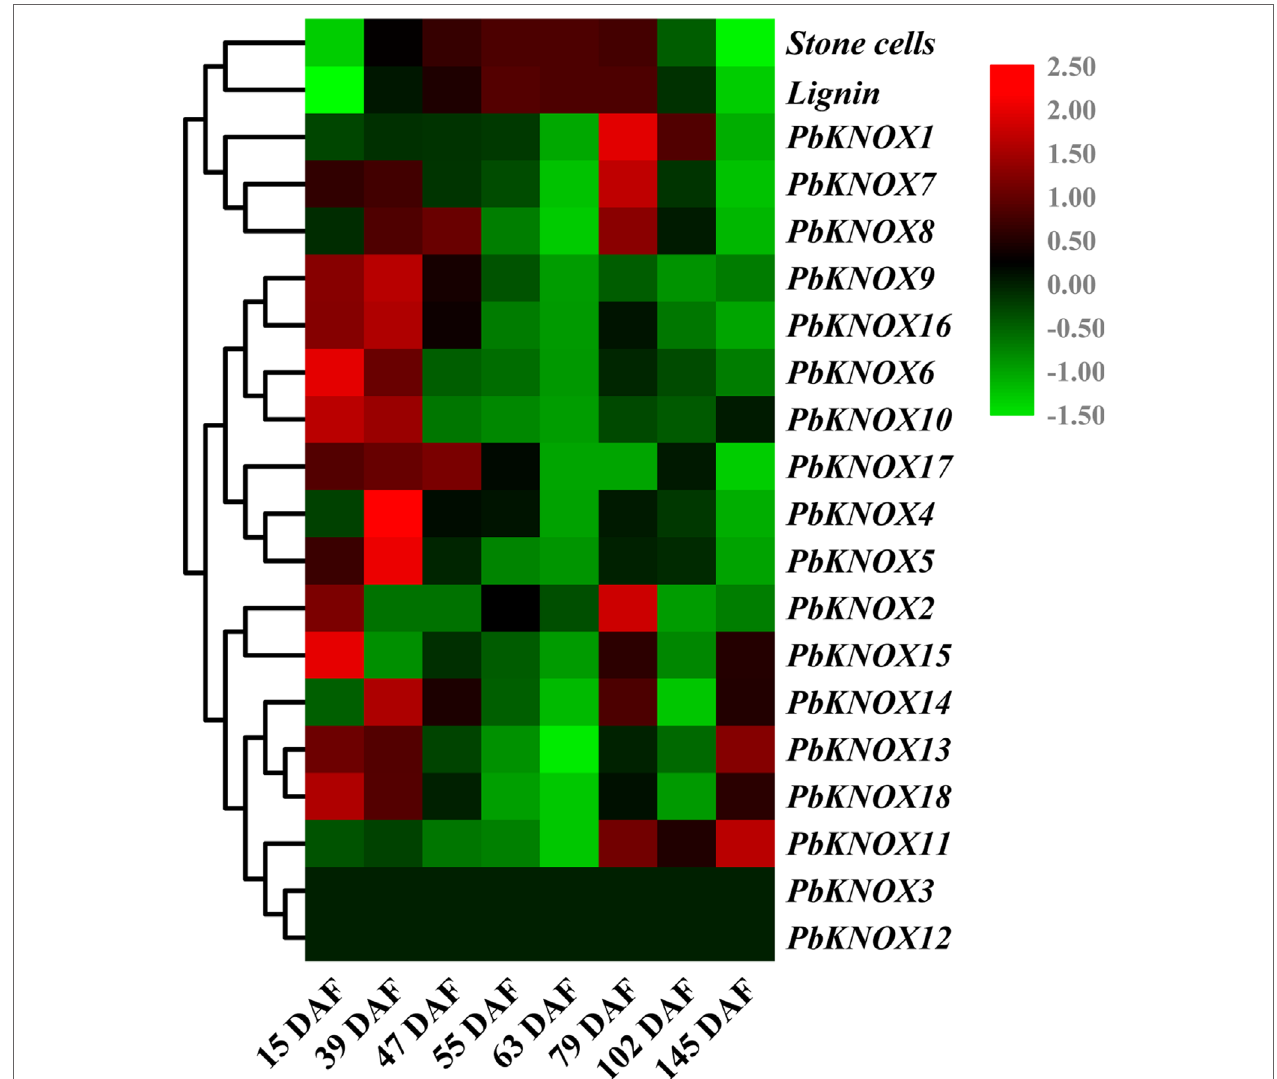
FIGURE 6 | Hierarchical clustering analysis of stone cell/lignin levels, and transcription levels of PbKNOX s in pear fruits at different developmental stages. The qRT-PCR results are presented in a heatmap, and the expression trends were clustered. Stone cells: percentage of stone cell content in pear pulp (%). Lignin: percentage of lignin content in pear pulp